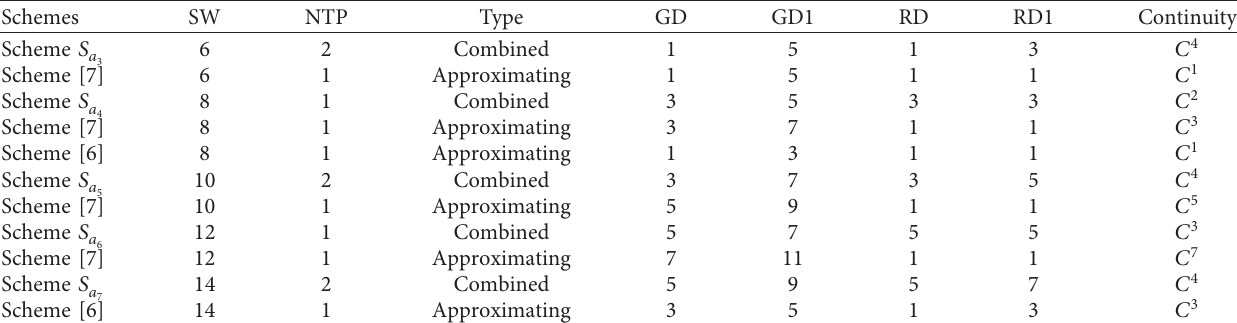
Table 9: Comparison of the proposed schemes with existing primal relaxed schemes having the same support width.